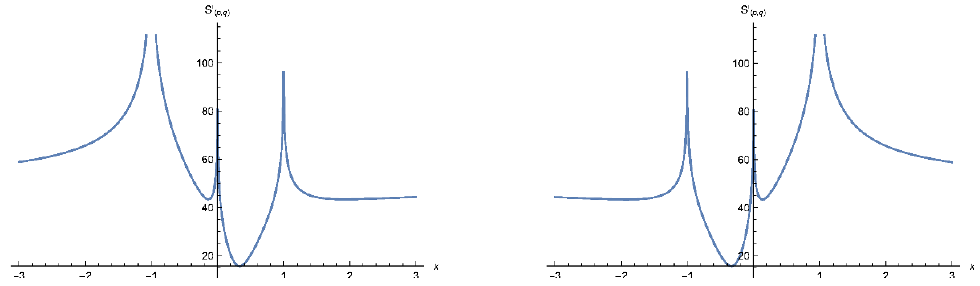
Figure 12 . The energy pro(cid:12)les of Sector 2 probe strings (left) and Sector 3 probe strings